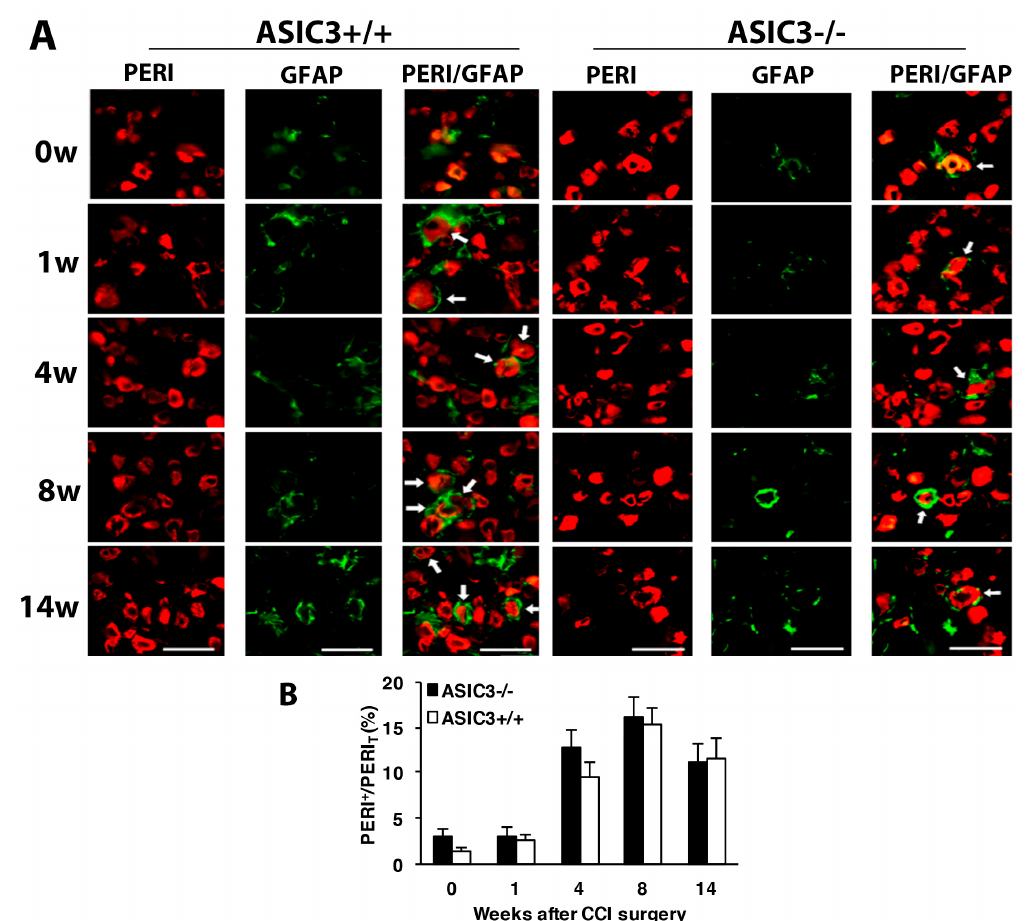
Figure 7. Number of satellite glial cells remains unchanged after ASIC3 deletion. The ipsilateral L5 DRG were excised from ASIC3 +/+ or ASIC3 − / − mice at 0, 1, 4, 8, 14 w after CCI surgery and co-stained with anti-GFAP and anti-PERI antibodies. ( A ) Cell images showing GFAP (green) or PERI (red)-positive neurons. Scale bar is 50 μ m. ( B ) Percentage of PERI-positive neurons surrounded by GFAP + cells (PERI GFAP+ ) to total PERI-positive (PERI T ) neurons. ASIC3 +/+ n = 601–1315 neurons; ASIC3 − / − n = 797–1302 neurons, n = 2–3 mice.